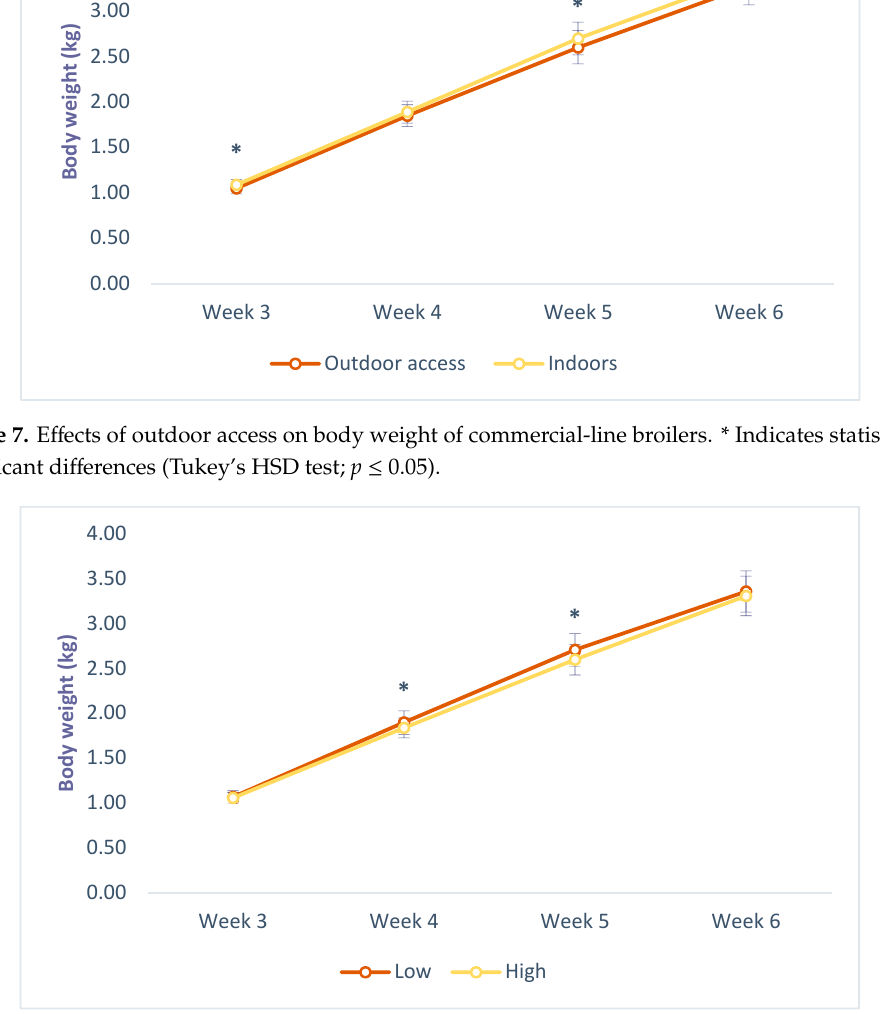
Figure 8. Effects of stocking density on body weight of commercial-line broilers. * Indicates statistically significant differences (Tukey’s HSD test; p ≤ 0.05).